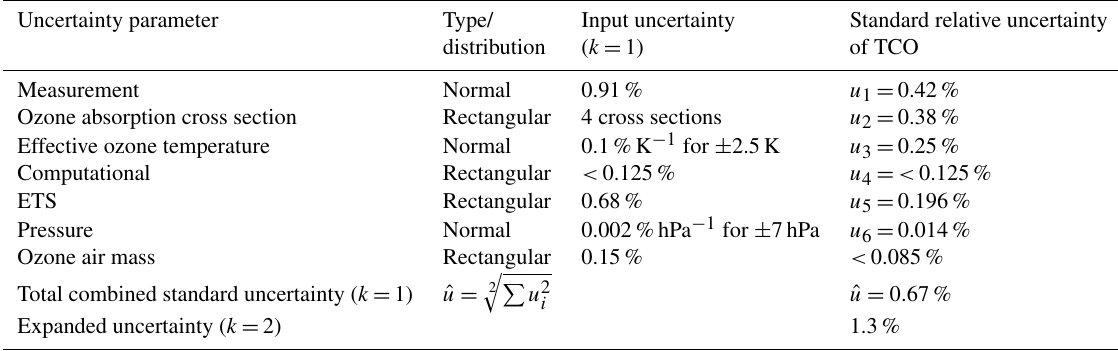
Table 1. Uncertainty budget for the TCO retrieval by the LSF algorithm applied to the QASUME spectroradiometer. Uncertainty